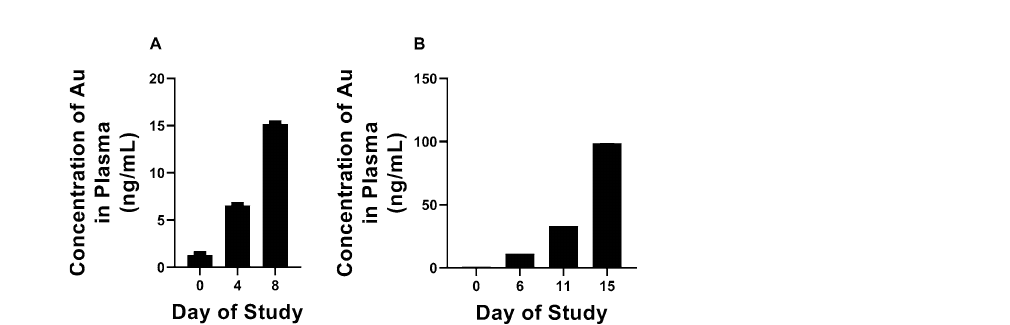
Figure 4. Histopathology of porcine skin tissues exposed to topical auranofin for 4, 7, or 14 days. Cutaneous sites exposed to topical auranofin were excised, formalin fixed, and evaluated using histopathology. No significant histologic lesions were seen in any drug applied topically, including toxicologic effects. ( A ) Vehicle control. ( B ) Pig 2, 2% auranofin for 4 days. ( C ) Pig 3, 1% auranofin for 14 days. ( D ) Pig 3, 3% auranofin for 14 days.